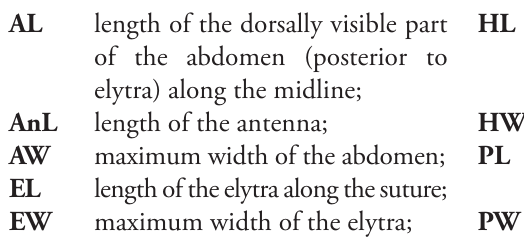
Type material (1 ex.). Holotype: CHINA: ♂ , labeled ‘China: Zhejiang Prov., Linan County ( 临安县 ), West Tianmushan ( 西天目山 ), 06.v.2012, 1200 m, Wen-Xuan Bi leg.’